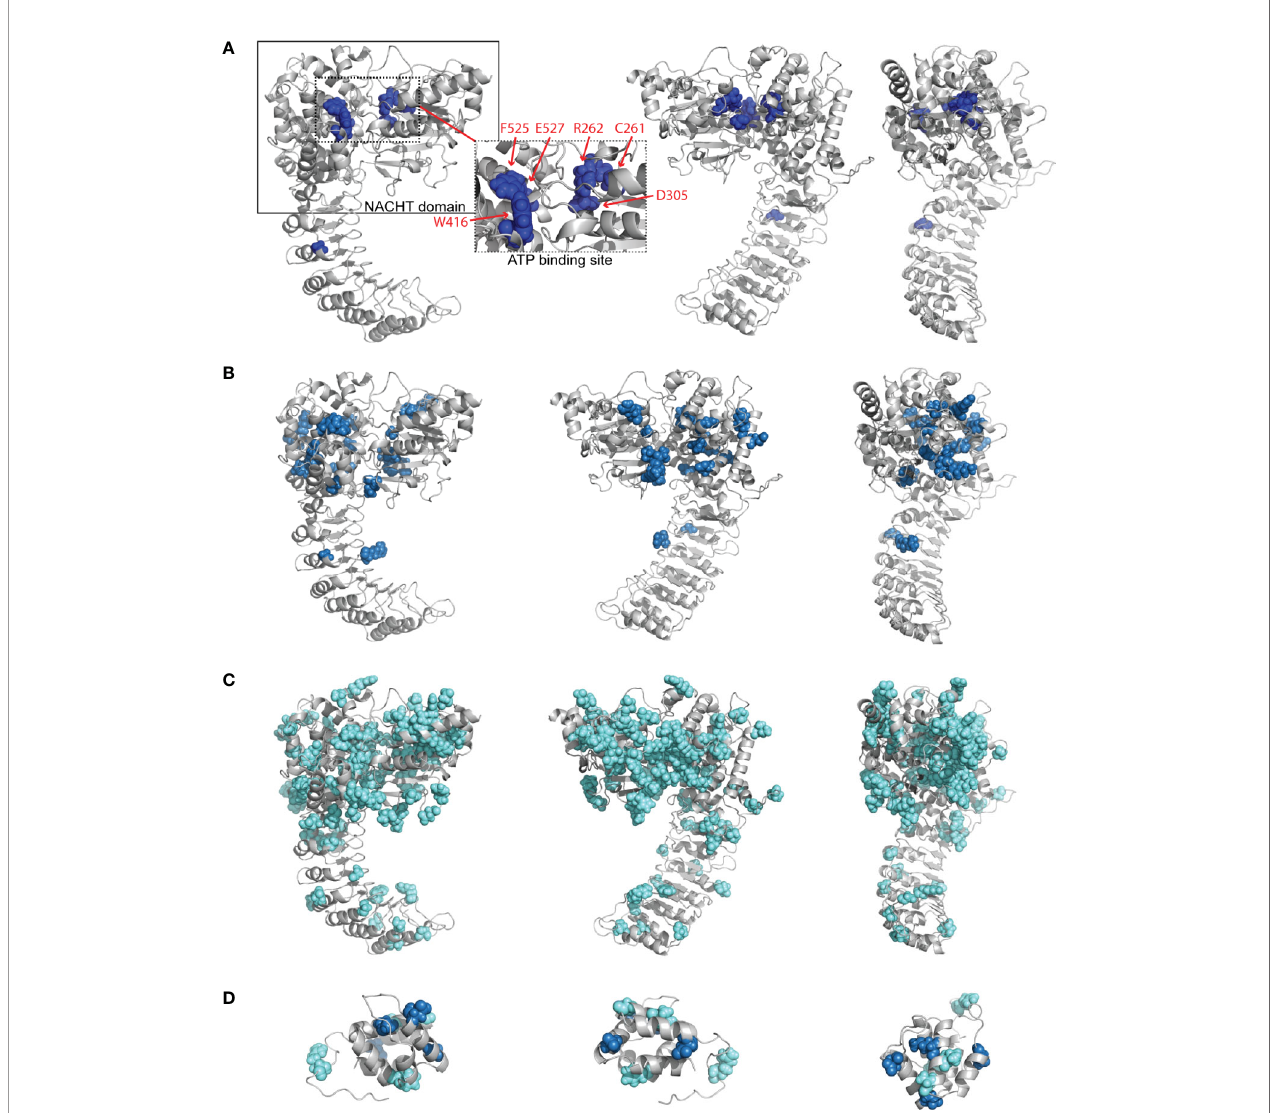
FIGURE 3 | Structurally Disruptive Mutation Sites. Representative locations of (A) severely-disruptive mutations ( p w < 0.01; boxes highlight NAIP CIITA HET-E TEP1 (NACHT) domain [solid line] and ATP binding site [dashed line]; inset shows enlarged ATP binding site with labeled mutation sites), (B) moderately-disruptive mutations (0.01 < p w < 0.05), and (C) mildly-disruptive mutations ( p w > 0.05) mapped on our NLRP3 homology model, which excludes mutations in the PYR domain and beyond Leu943. (D) All germline mutations in PYR mapped on the NLRP3 PYR crystal structure. Severely-disruptive mutations in deep blue, moderately- disruptive mutations in pale blue, mildly-disruptive mutations in cyan